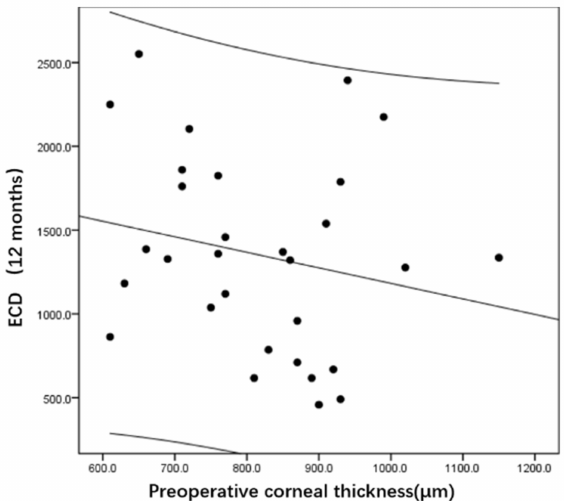
Figure 4. Relationship between the ECD after DSAEK (12 months) and the preoperative corneal